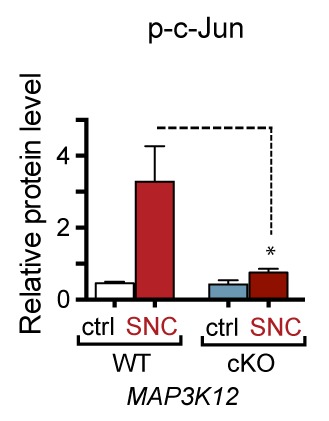
Quantification of p-c-Jun immunoblots presented in Figure 3a (DLK-deficient L3/L4 DRGs 24 hr after SNC, n = 3/condition).